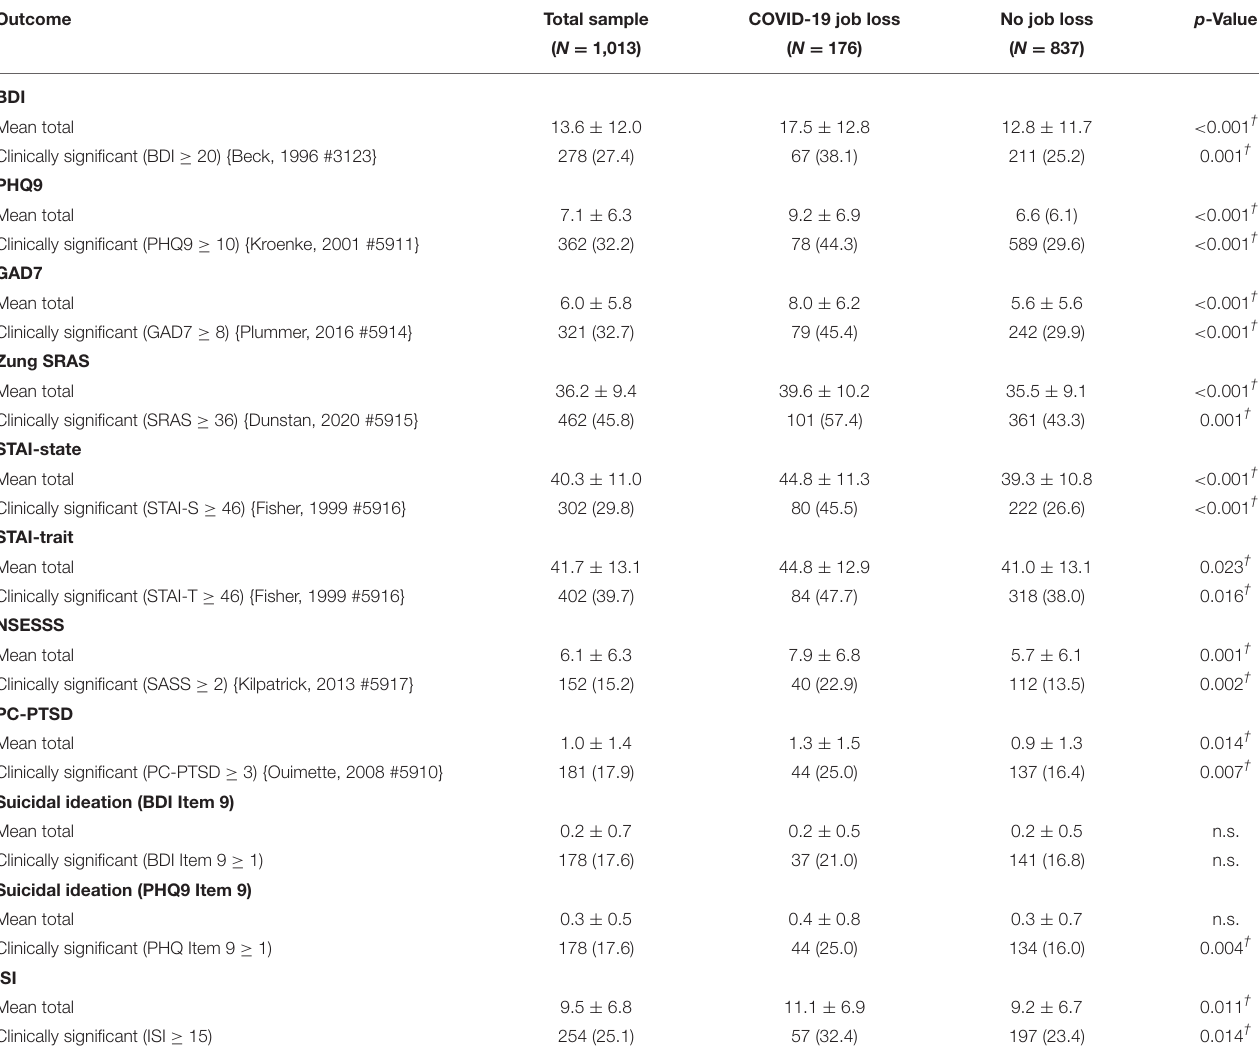
TABLE 2 | Mean scores and percent meeting clinical cut-offs on mental health outcomes between groups of individuals who lost or did not lose their primary employment due to the pandemic.